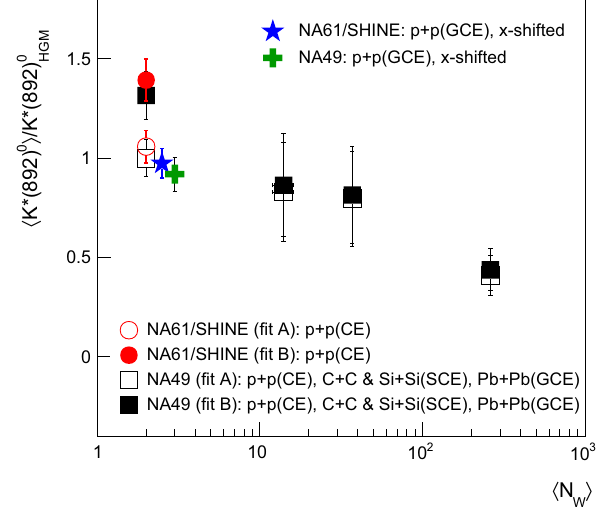
Fig. 15 The mean multiplicity of K ∗ ( 892 ) 0 for p+p reactions (this analysis and NA49 measurement [4]), as well as results of NA49 for C+C, Si+Si and Pb+Pb [4] interactions at 158 A GeV / c divided by the HGM predictions [41] for fit B (closed circle and closed squares) and fit A(opencircleandopensquares),seethetextfordetails.Closedstarand cross symbols show p+p measurements compared to HGM predictions for the Grand Canonical Ensemble formulation [42,43]. N W denotes the number of wounded nucleons taken from Ref. [4]